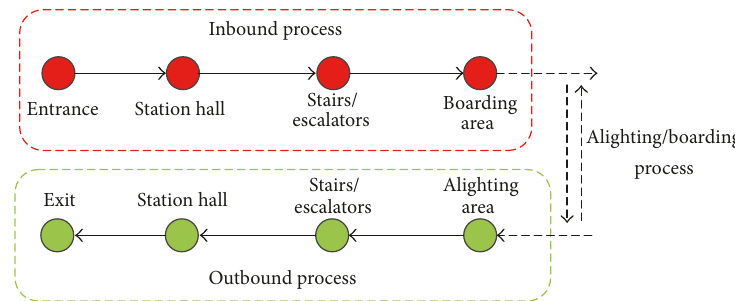
Figure 1: Inbound and outbound process at the subway